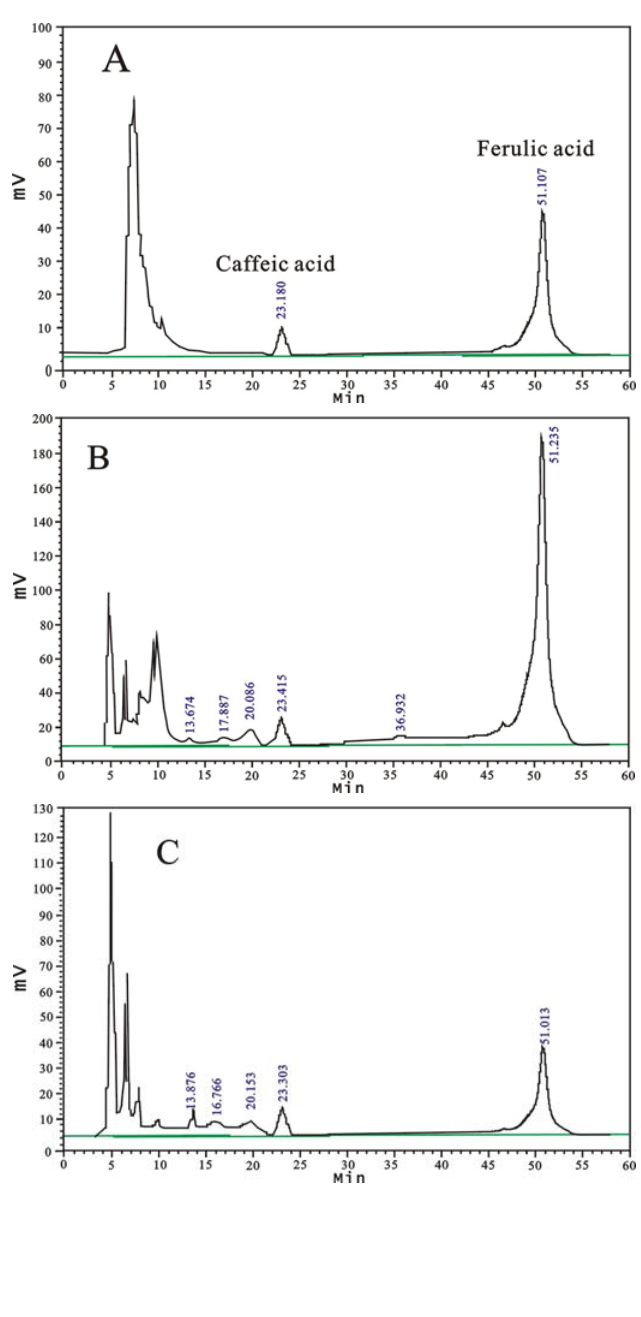
Figure 2. HPLC chromatograms of: (A) caffeic acid and ferulic acid (the standards), (B) ethyl acetate extract (EAE) and (C) water extract